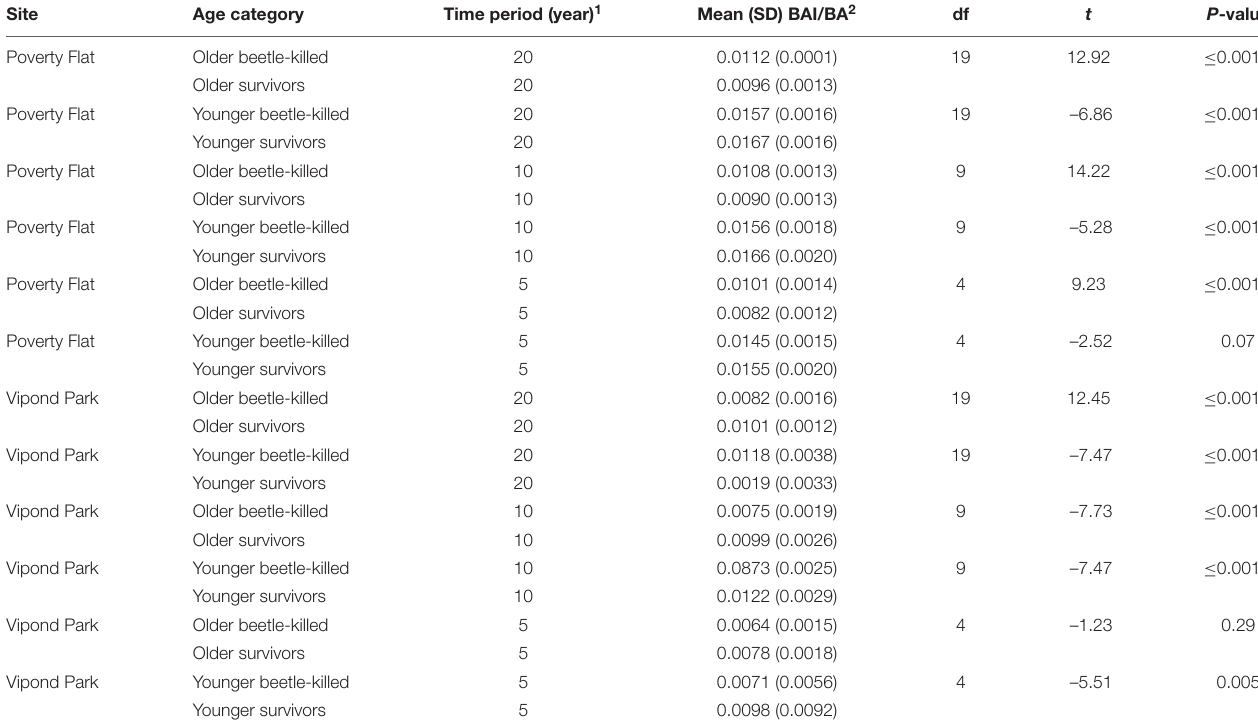
TABLE 7 | T -test comparisons of mean annual BAI/BA for older and younger (see text) beetle-killed vs. survivor Pinus albicaulis at Poverty Flat, ID, and Vipond Park, MT, over 20, 10, and 5 years prior to Dendroctonus ponderosae outbreak.